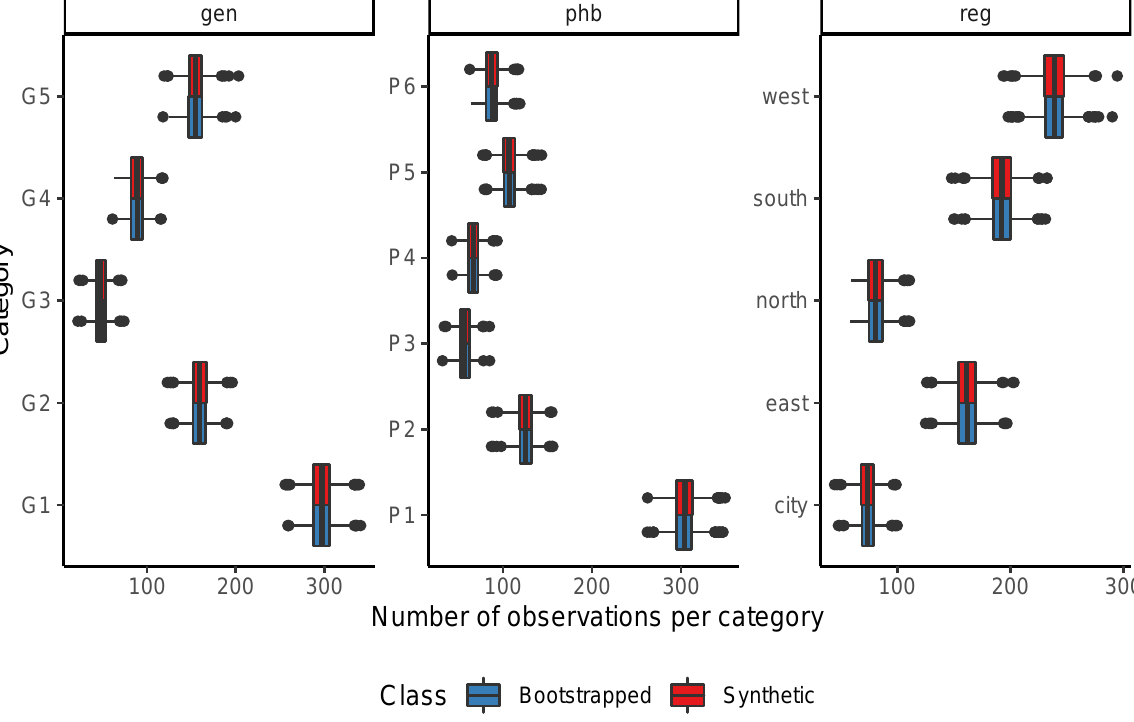
Figure 2. Empirical sampling distribution of the number of observations within each category of the categorical variables in the bootstrapped and synthetic boys